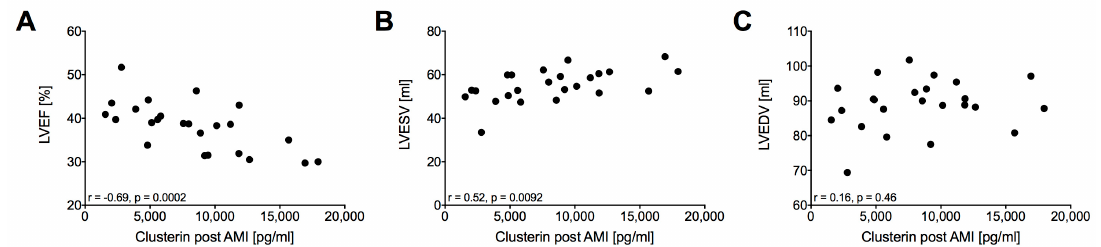
Figure 5. Correlation of plasma clusterin post AMI with LVEF ( A ), LVESV ( B ) and LVEDV ( C ) 120 min after AMI onset ( n = 24).